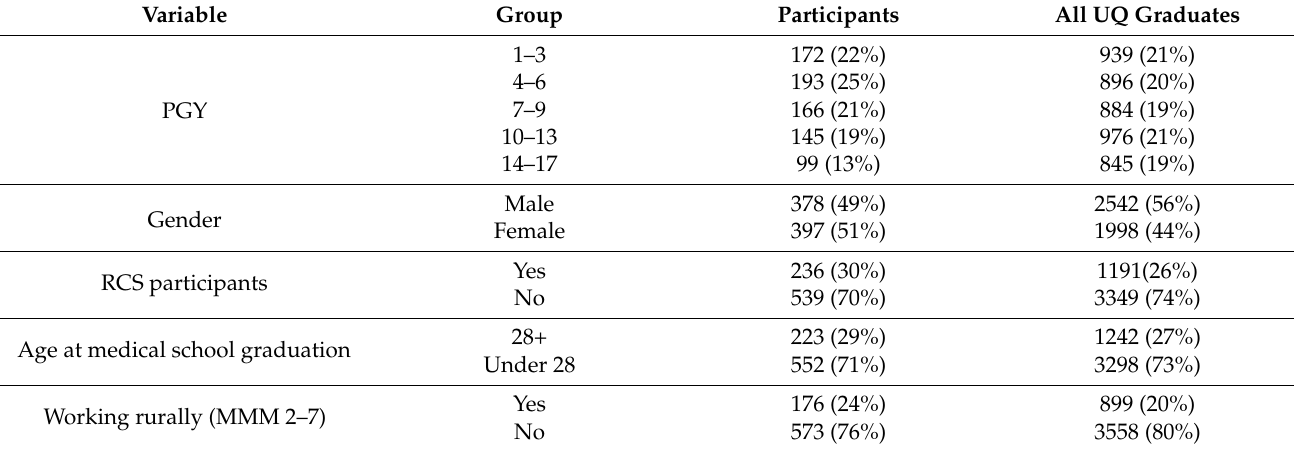
Table 1. Summary of participants in the medical graduate outcomes study (2019), compared against all invited graduates.